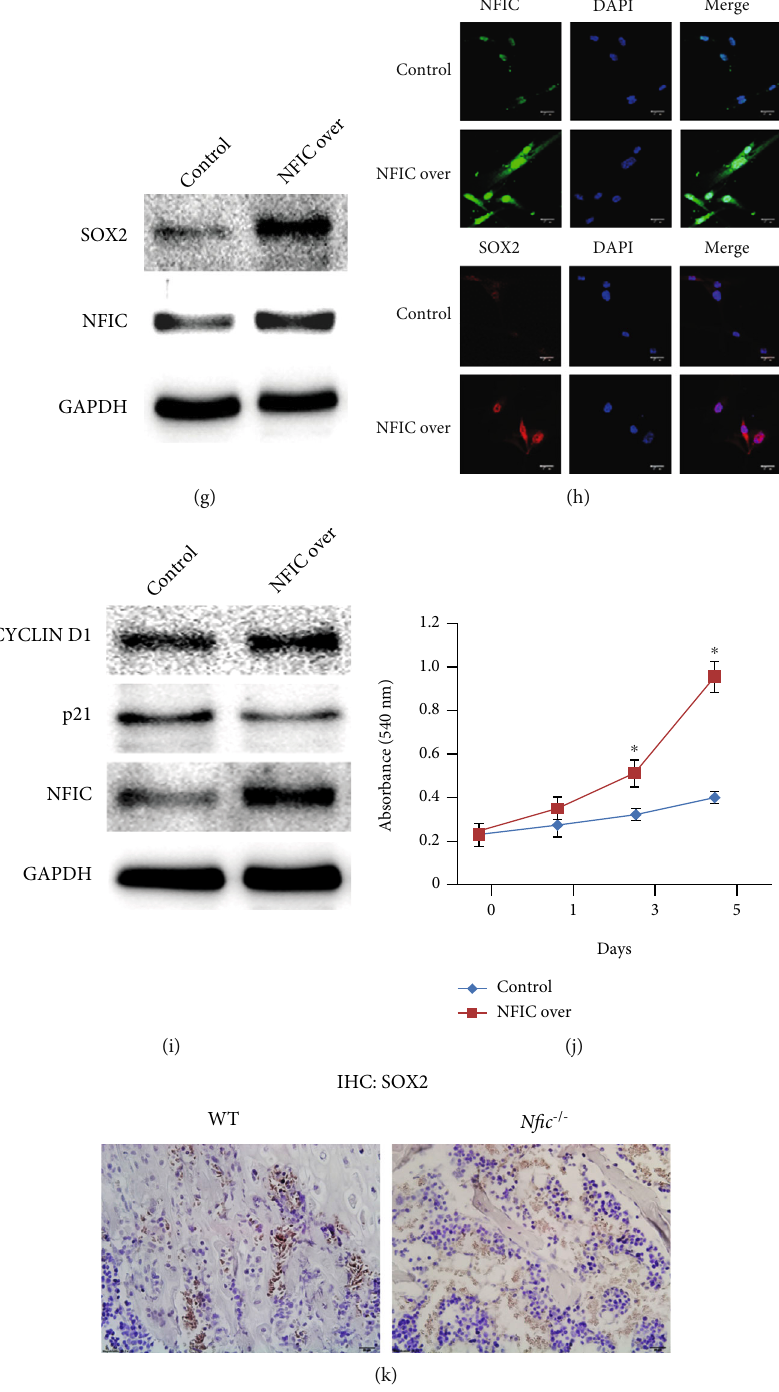
Figure 5: N fi c regulates Sox2 expression in DPSC (a – e) and BMSC (f – j). (a) Sox2 mRNA and (b) protein expression levels were analyzed in control and N fi c -overexpressing DPSC. n = 5 , ∗ p < : 05 . (c) Sox2 expression in vitro examined in cultured DPSC under fl